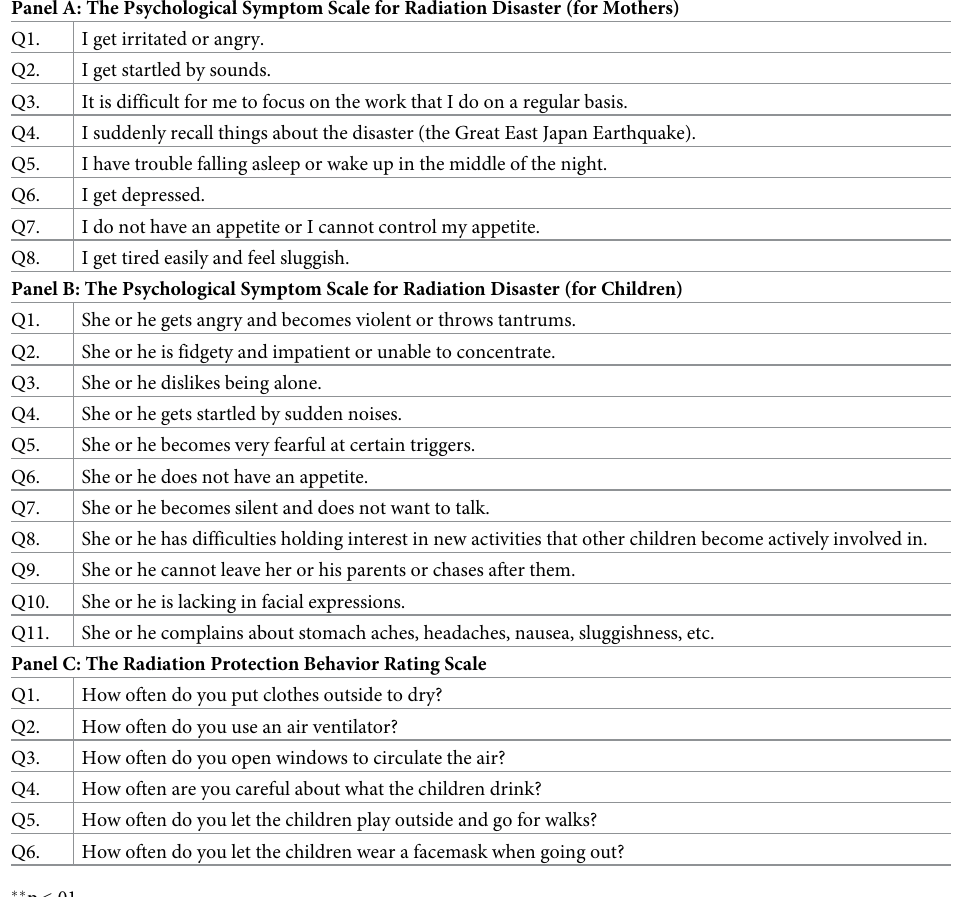
Table 2. Panel A: The Psychological Symptom Scale for Radiation Disaster (for